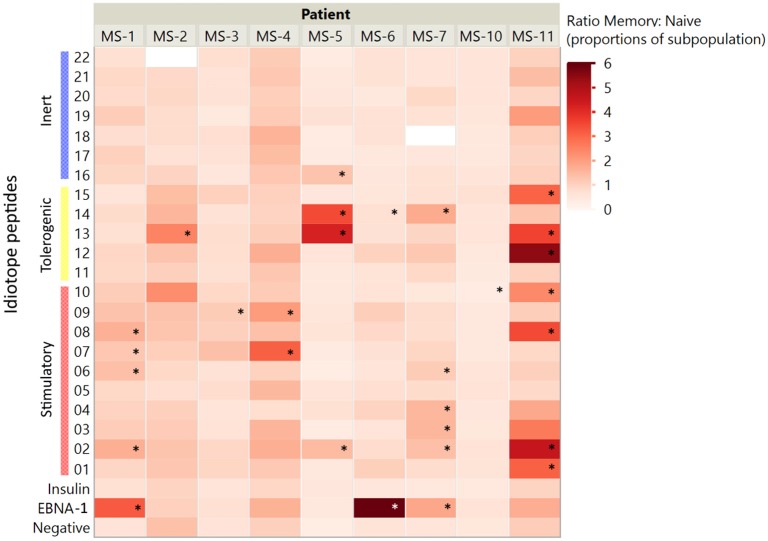
Memory to naïve activation ratios. The ratios of activated CD4+ cells (% of CD45RO+ memory:% of CD45RO− naïve cells) were assessed for all idiotope peptides. A higher ratio indicates a higher proportion of responder cells among memory CD4+ T cells than among naïve cells. The idiotope peptides that elicited memory T cell responses three times higher than the unstimulated control are marked with *.